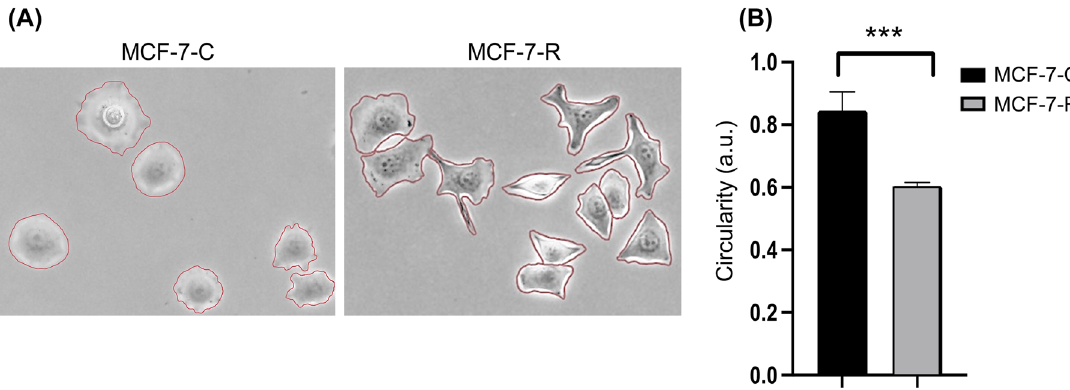
Figure 3: Circularity analysis of DAPT resistant and control cells. (A) Representative phase-contrast images of MCF-7-C and MCF-7-R cells plated in a drug-free medium. Red outlines representing the cell borders were used to calculate circularity. (Scale bar, 50 μ m). (B) The circularity values (a.u) of control and resistant cells are shown. Data represent the means and ± SD of randomly selected 200 cells (***p<0.001).